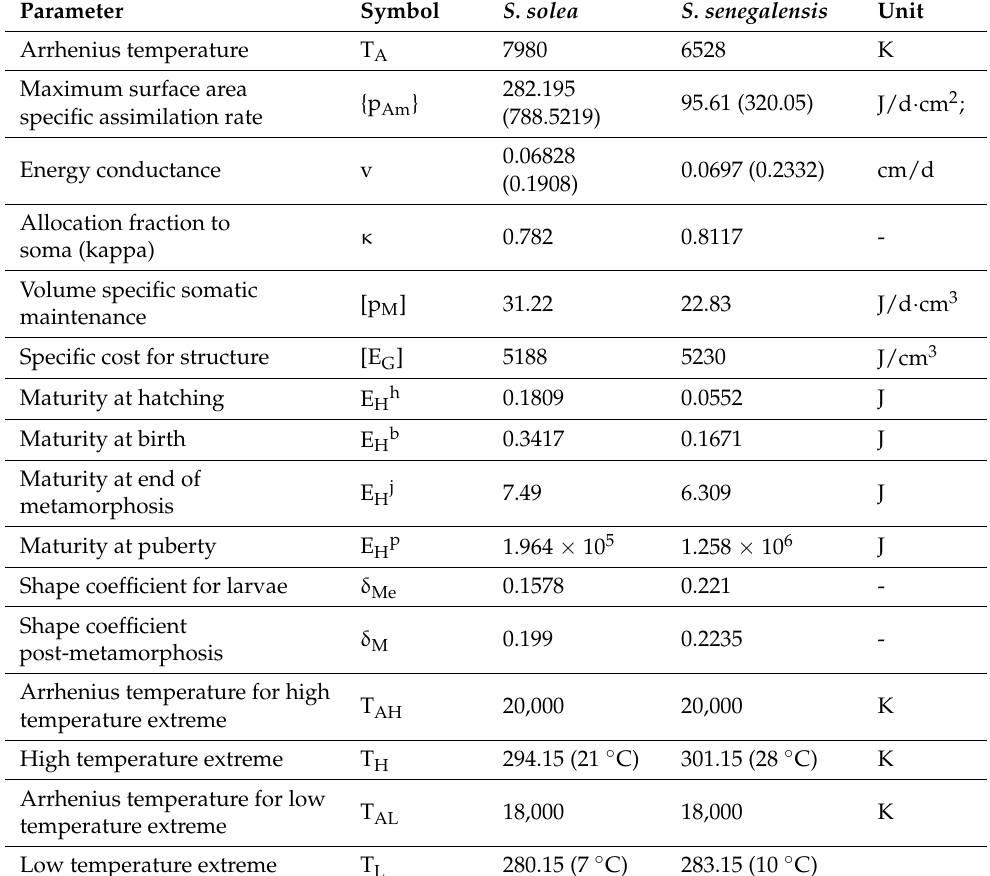
Table 2. Summary of DEB parameter estimates for the common sole ( S. solea ) and the Senegalese sole ( S. senegalensis) that were used for the simulations. Two parameters (v and {p Am }) in the abj-model applied here increase their value between birth and metamorphosis (see Appendix A), so the final value is provided in brackets. The final parameter value is calculated by multiplying the initial value by s M = 2.7942 ( S. solea) or by s M = 3.3472 ( S. senegalensis ), s M calculated for f = 1. Arrhenius parameters for the 5-parameter temperature correction (T L , T H , T AL , T L ) were set manually. For a full list of parameters, please see Tables A3 and A5 in Appendix